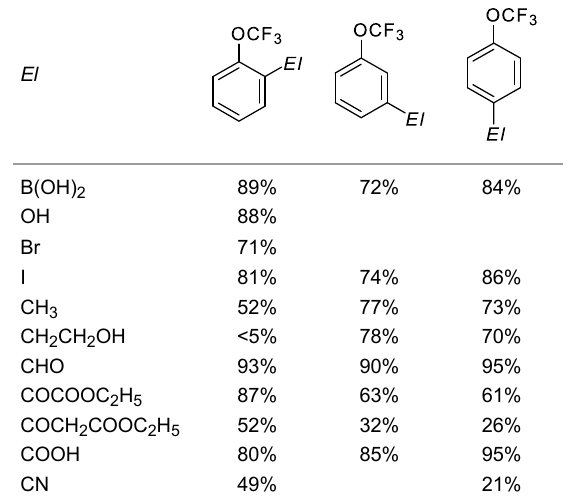
Table 8: Reaction of 2-, 3- and 4-(trifluoromethoxy)phenyllithiums and